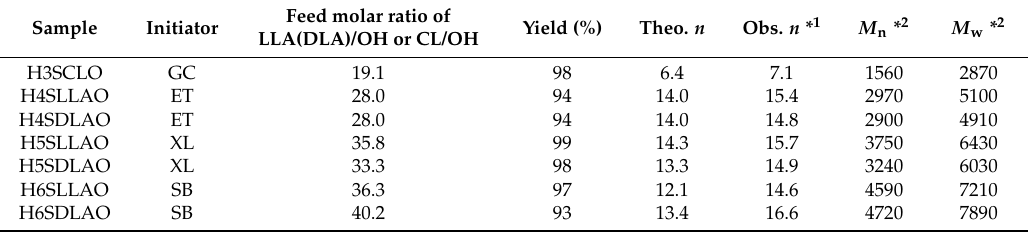
Table 1. The feed molar ratios, yields and n values of H m SLLAOs, H m SDLLAOs and